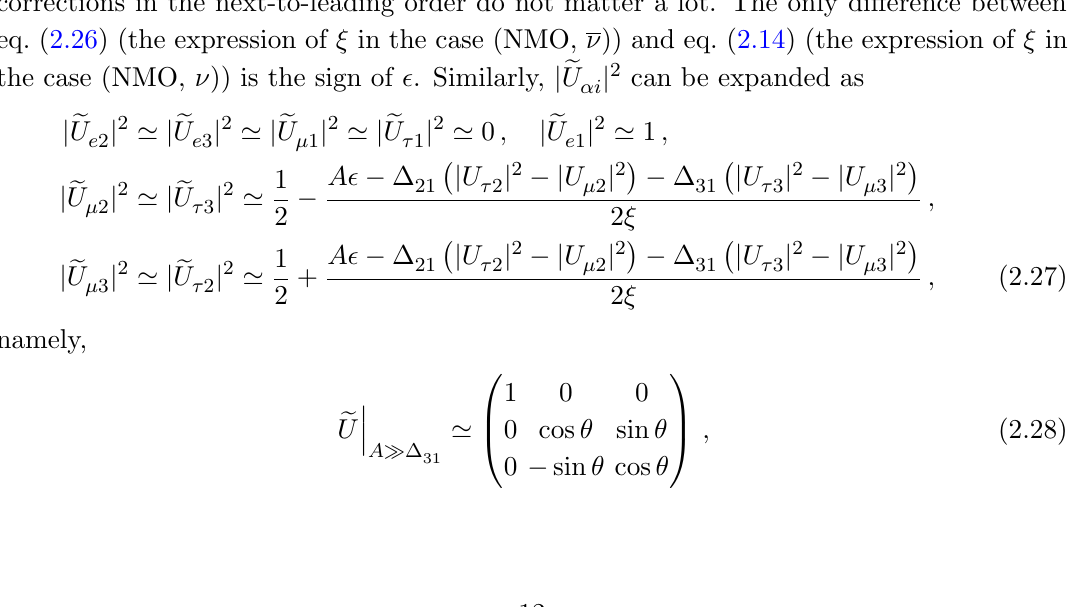
2 (for (cid:11) = e , U (cid:11)i j j e ; (cid:18) ; (cid:18) ; (cid:14); (cid:1) ; (cid:1) ) in refs. [36, 37] have been 12 13 23 21 31